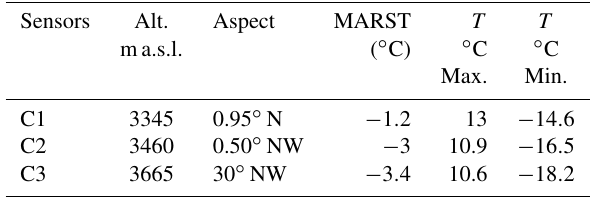
Table 1. Key information and data recorded by ground temperature sensors between 1 September 2016 and 1 September 2019 (3 years of records).